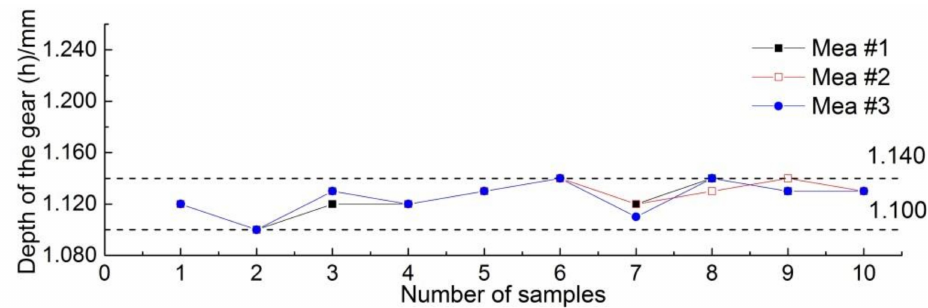
Figure 12. The depth of the 10 gears measured by the third operator (three measurements each sample).